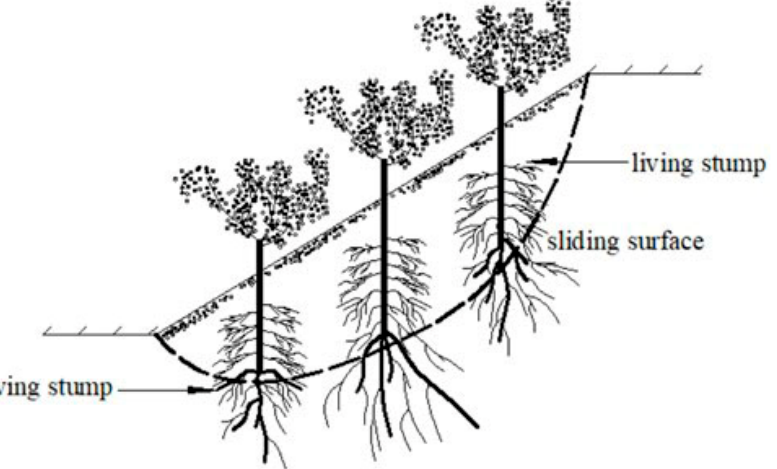
Figure 1. The slope reinforced with the living